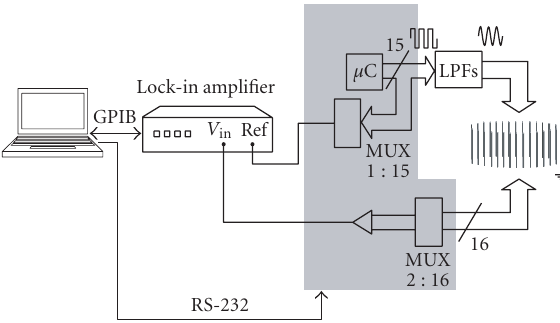
Figure 3: Implemented system for demonstrating the feasibility of the FDM EIT technique. The electrode setup and the liquid con- tainer are represented on the right.